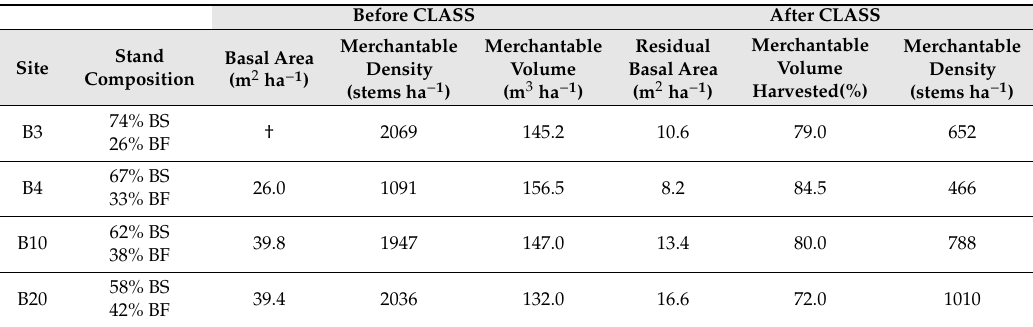
Table 1. Description of sampling sites before and after careful logging around small merchantable stems (CLASS). Merchantable refers to stems with a DBH > 9.1 cm. BS = Black spruce, BF = Balsam fir.